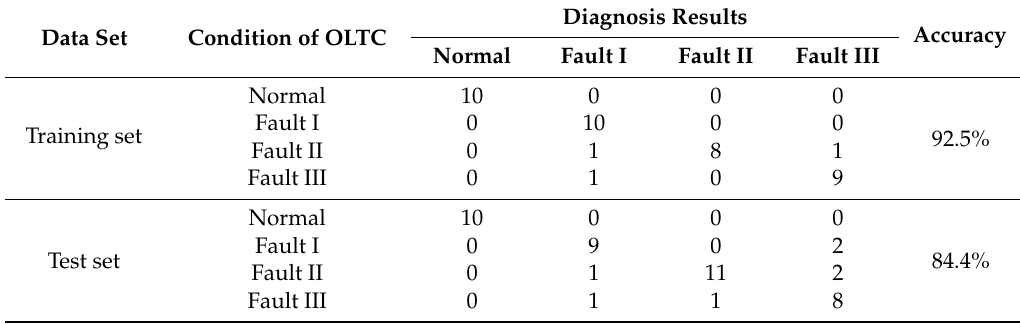
Table 5. Diagnostic results of harmony search optimization-relevance vector machine (HS-RVM).